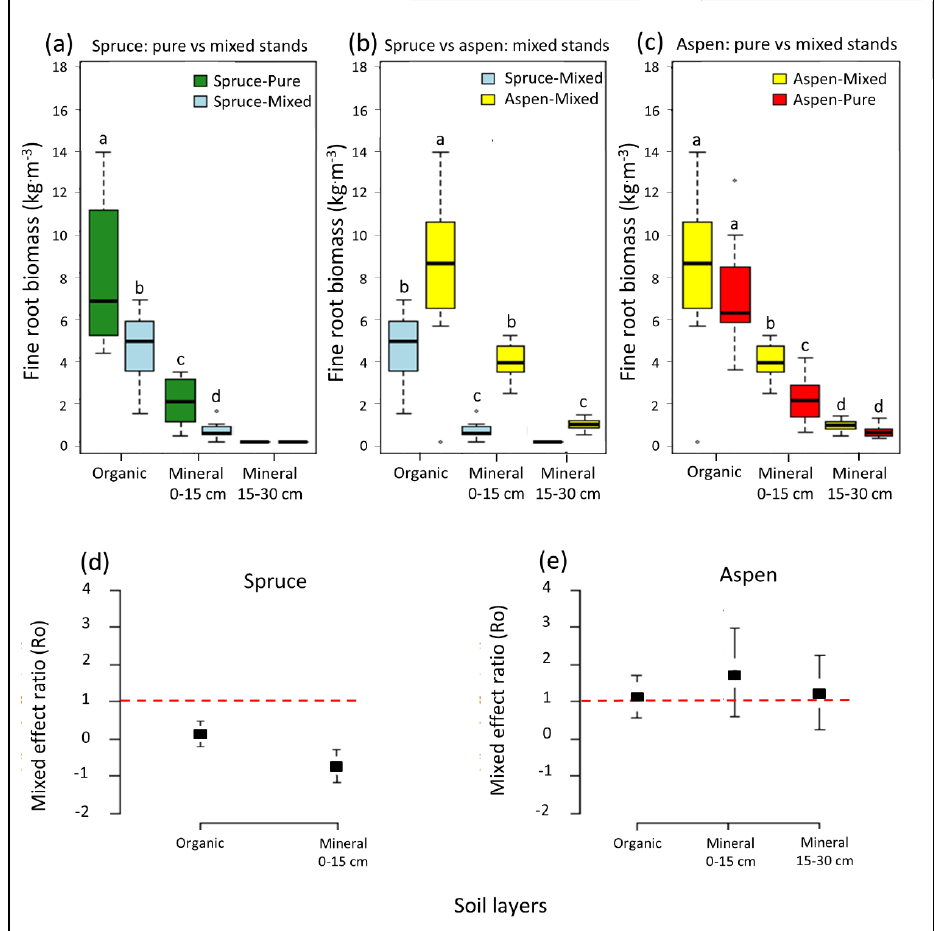
Figure 2. Di ff erences in soil volume filling by fine roots of black spruce and trembling aspen in the three sampled soil horizon layers ( a , c ) between pure and mixed stands, and ( b ) within mixed stands. Species mixture e ff ect on fine roots biomass of ( d ) black spruce and ( e ) trembling aspen in di ff erent soil horizon layers. In ( a – c ), the box represents 50% of the data set, distributed between the 2nd and 3rd quartiles. The median divides the box into the interquartile range. The lower and upper whiskers represent the minimum and maximum quartiles. For each soil layer, the number of samples n = 12 (i.e., 3 sites × 4 transects). Null values indicate that no root biomass was recorded in the soil layer on the transect. In ( b ), points represent average Ro values ( n = 3), bars the 95% confidence interval, and the red dotted line the threshold under or over which the e ff ect is considered as negative or positive. Statistical di ff erences among pairwise comparison at p = 0.05 within each soil layer are denoted by